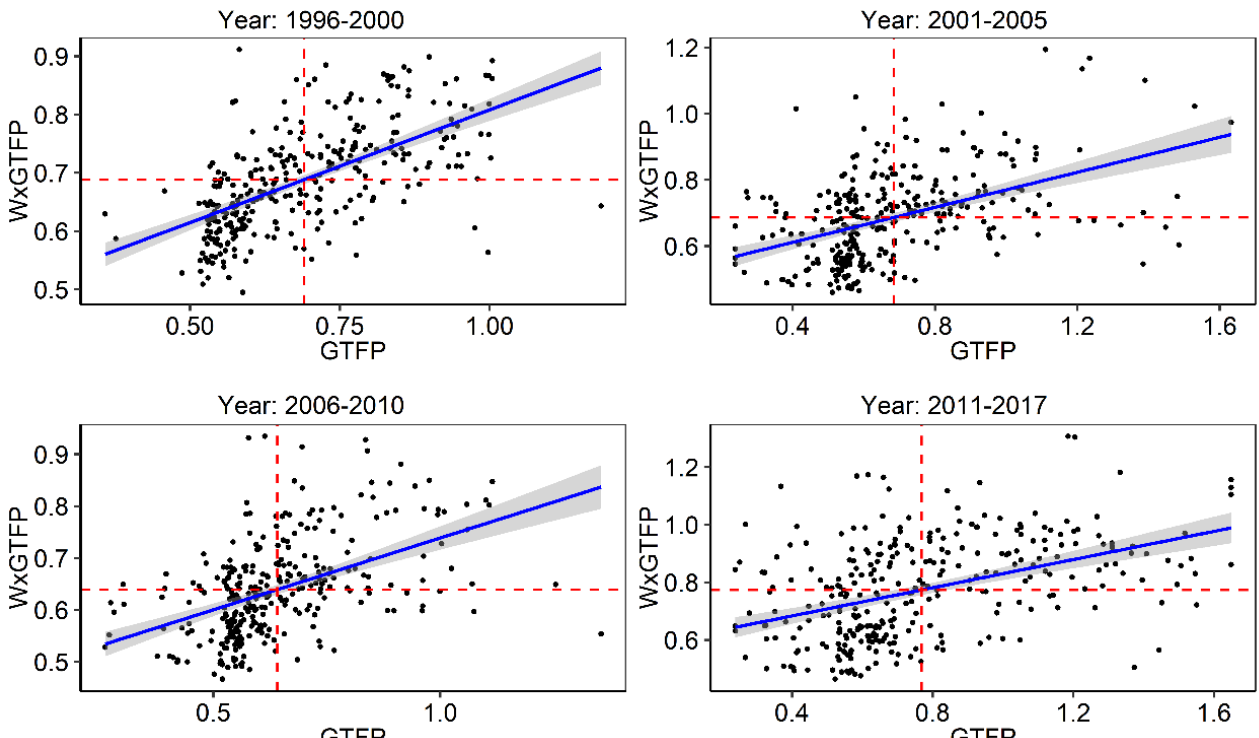
Figure 2. Global Moran scatter map of GTFP.